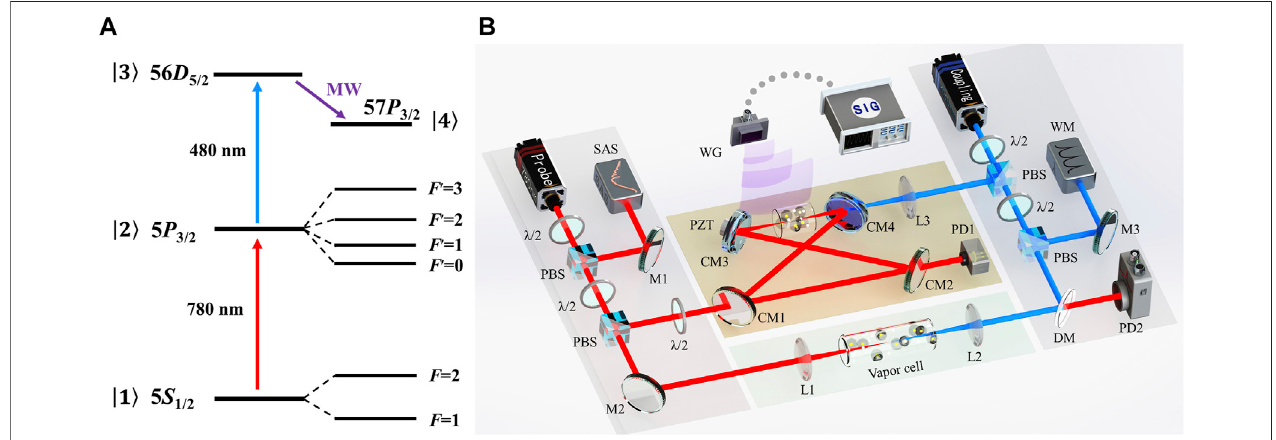
FIGURE 1| (A) Relevantenergylevels of 87 Rb atoms. (B) Experimental setup. λ /2, half-wave plate; M, mirror; CM, cavity mirror; DM, dichroic mirror; L, lens; AOM, acousto-optic modulator; PD, photodiode; SAS, saturation absorption spectroscopy; WM, wavemeter; SIG, signal generator; PZT, piezo-electric transducer; PBS, polarization beam splitter; WG,